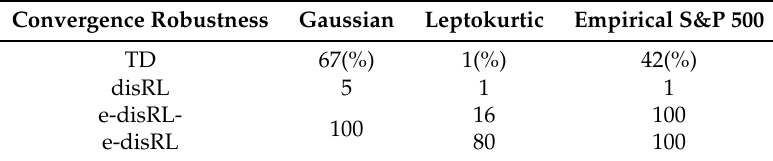
Table 2. Percentage of game plays where the artificial agent attained the optimal policy at the end of episodes 11-200. Convergence Robustness is the percentage of 100 game plays where the agent’s chosen policy is the optimal one at the end of episodes 11-200. Each episode consists of 100 trials. First 10 episodes are excluded because exploration takes place. Learning is allowed throughout all episodes. Learned Q values carry over across episodes. Percentages are averaged over the two states. The Convergence Robustness of e-disRL- and e-disRL in the Gaussian case is the same, because the maximum likelihood estimator of the mean (used in e-disRL) equals the sample average (used in